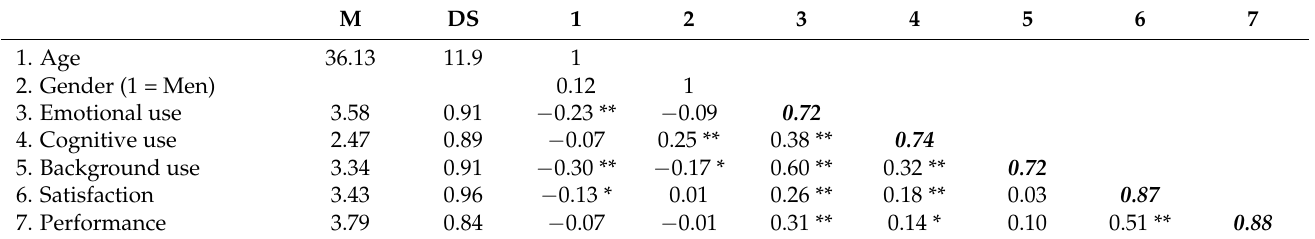
Table 2. Means, standard deviations, correlation, and reliability coefficients.